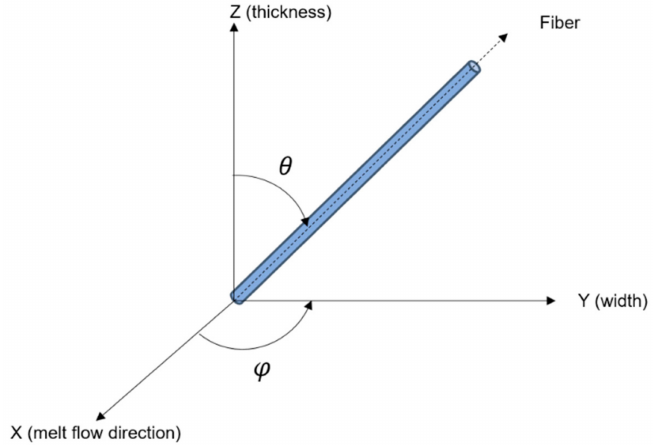
Figure 1. Orientation angles